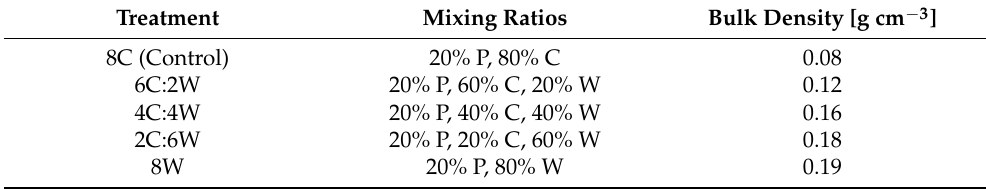
Table 2. Mixtures of investigated growing media. P: Perlite, C: Cocodust, W: Green waste compost. In all treatments, the perlite ratio is 20% and is thus omitted in treatment naming.